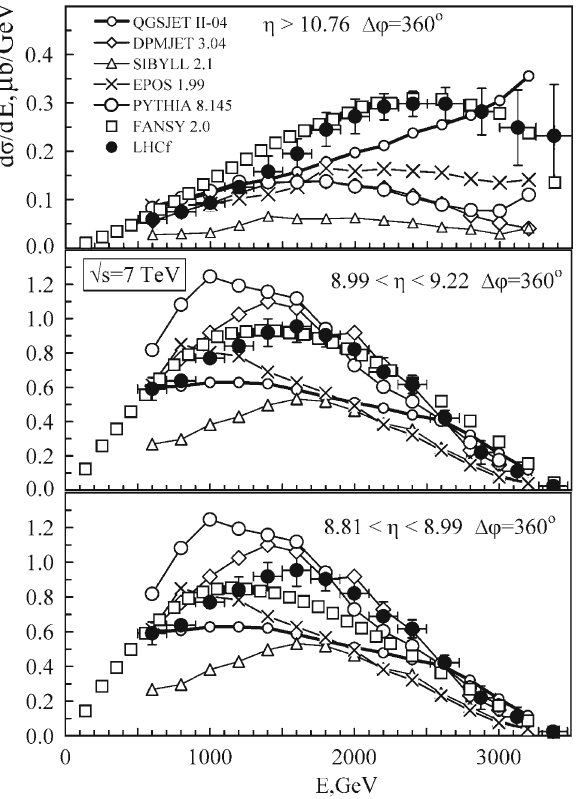
Fig. 7 ExperimentalLHCf(filledcircles)[39]“neutron” d σ/ dE cross sections at η > 10 . 76, 8 . 99 < η < 9 . 22, 8 . 81 < η < 8 . 99 (from top √ s = 7 TeV. Results obtained with the use of to bottom), Δφ = 360 ◦ , ◦ FANSY 2.0 QGSCPG ( (cid:2) ), QGSJETII-03 ( ) [26,27], DPMJET 3.04 ( (cid:3) ) [28], SIBYLL 2.1 ( (cid:11) ) [29–31], EPOS 1.99 ( × )[32,33], PYTHIA 8.145 ( (cid:4) )[34] models are shown as well